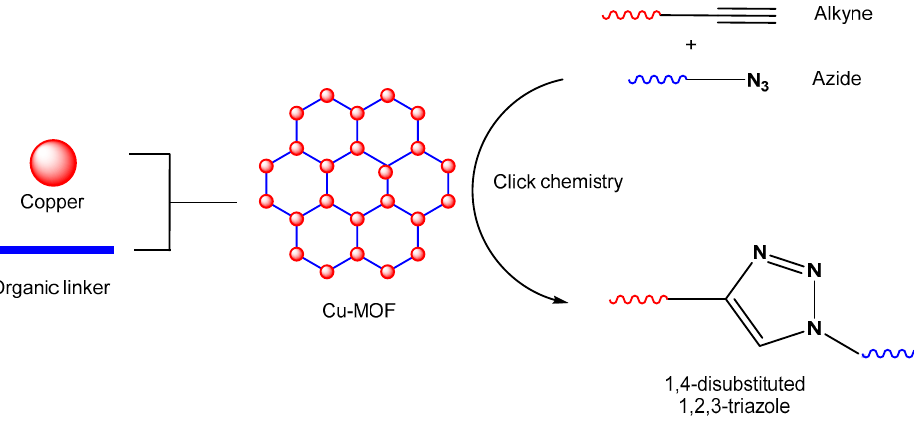
Figure 1. An illustration of MOF assembly and subsequent use in click chemistry. The coordination number, geometry, and functional assembly in MOFs play a dom- inant role in shaping the structure of the framework. MOFs have been found to display a wide range of supplementary binding unit (SBU) geometries, such as the octahedron, the